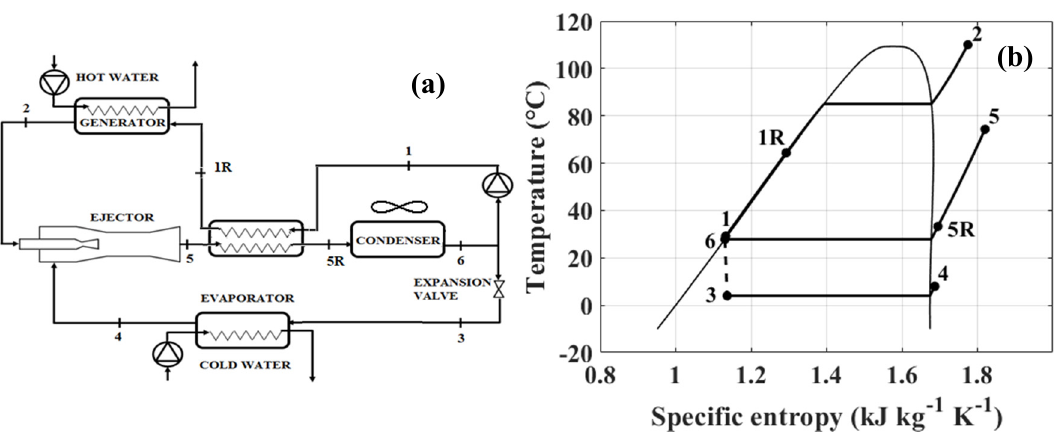
Figure 1. ( a ) Schematic layout. ( b ) Example of an ejector cooling cycle on T-s diagram for the fluid R1234ze.